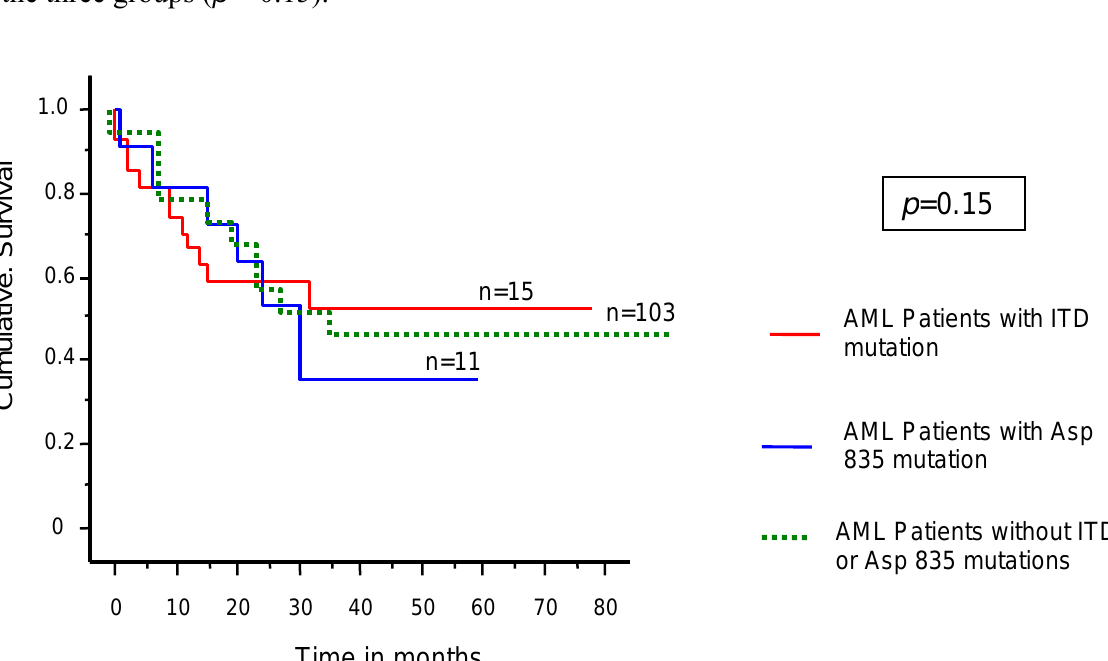
Figure 5. Kaplan-Meier cumulative survival analysis for AML patients with Asp 835 and ITD mutations and AML patients without mutations. Blue line indicates patients with Asp 835 mutation, red line indicates patients with ITD mutations and green line patients without flt3 mutations. The survival analysis showed no significance differences between the three groups ( p =